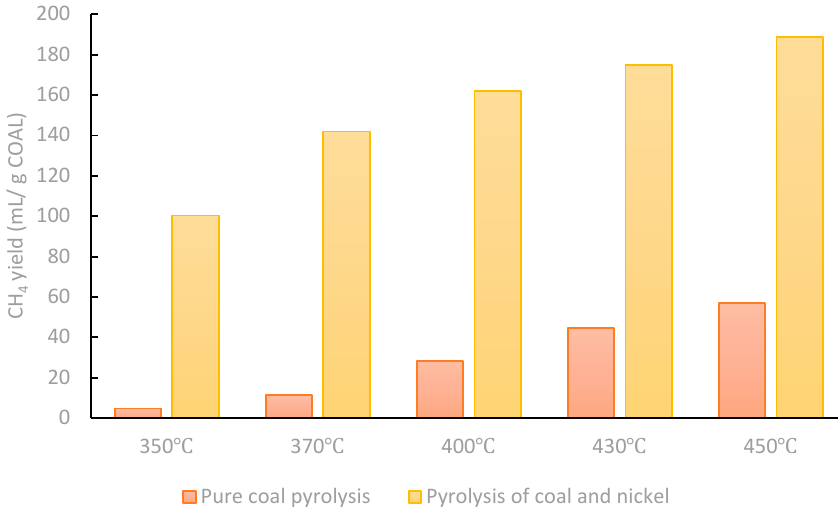
Figure 2. Variation diagram of pyrolysis yield of increasing Ni (Adapted from [80]).